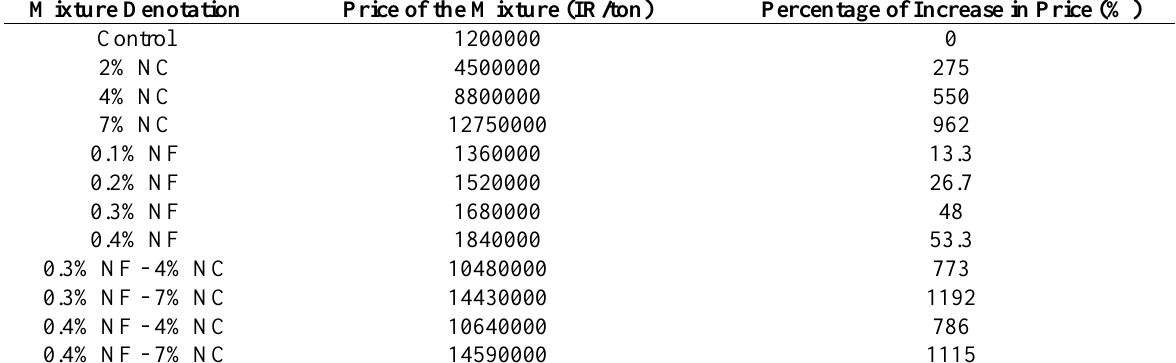
Table 7. Cost analysis of the mixtures